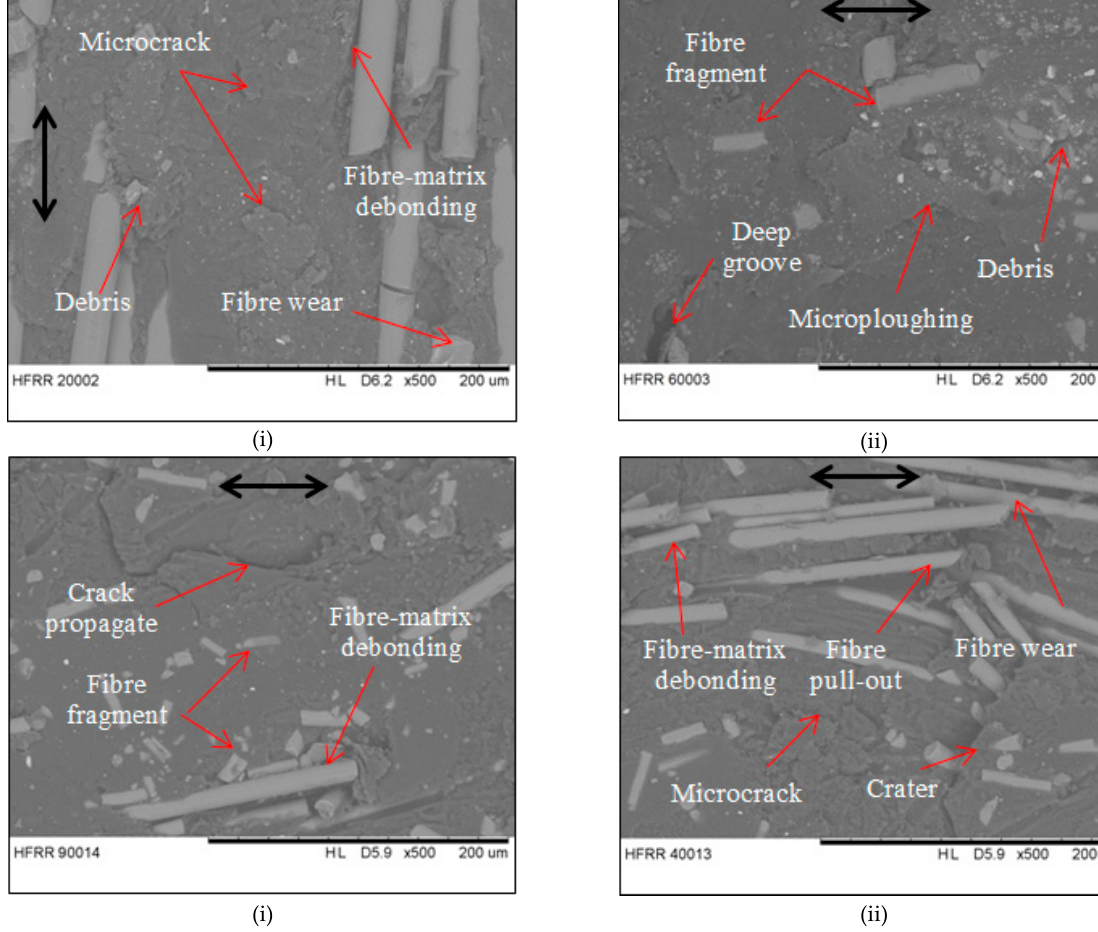
Figure 8. SEM micrograph of worn surface of ( a ) EP/GF and ( b ) EP/BF composites at (i) B-O-F and (ii) C-O-F sliding